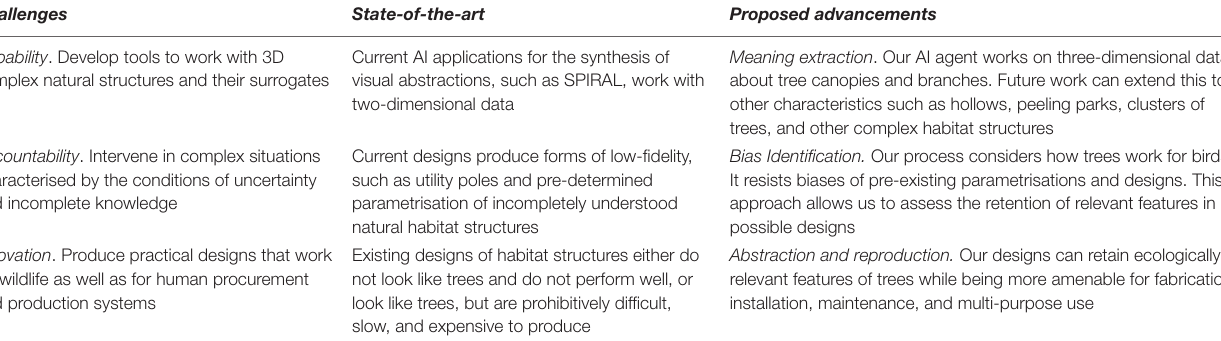
TABLE 1 | Results overview, meaning, and potential. Challenges State-of-the-art Proposed